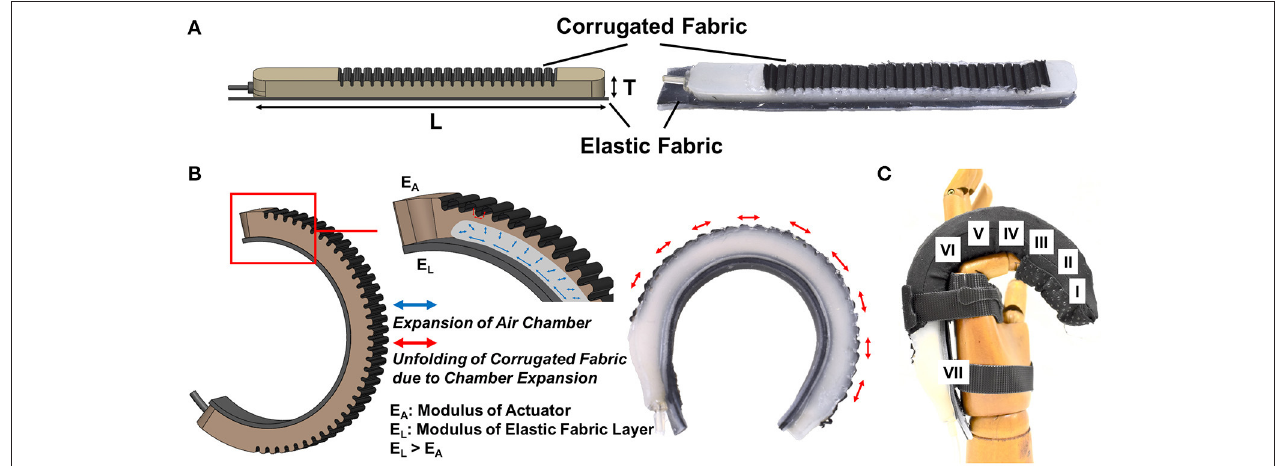
FIGURE 1 | (A) A fabric-reinforced soft actuators with a corrugated fabric layer and an elastic fabric later [Actuator thickness, T = 12mm, and length, L = 160mm (Thumb), 170mm (Little Finger), 180mm (Index & Ring Fingers), 185mm (Middle Finger)]. (B) Upon air pressurization, the corrugated fabric layer unfolds and expands due to the inflation of the embedded pneumatic chamber. Radial budging is constrained when the corrugated fabric layer unfolds fully. The elastic fabric elongates during air pressurization and stores elastic energy. The actuator achieves bending and extending motions at the same time. (C) A bending motion is preferred at the finger joints (II, IV, VI). An extending motion is preferred over the bending motion at the finger segments (I, III, V) and the opisthenar (VII).